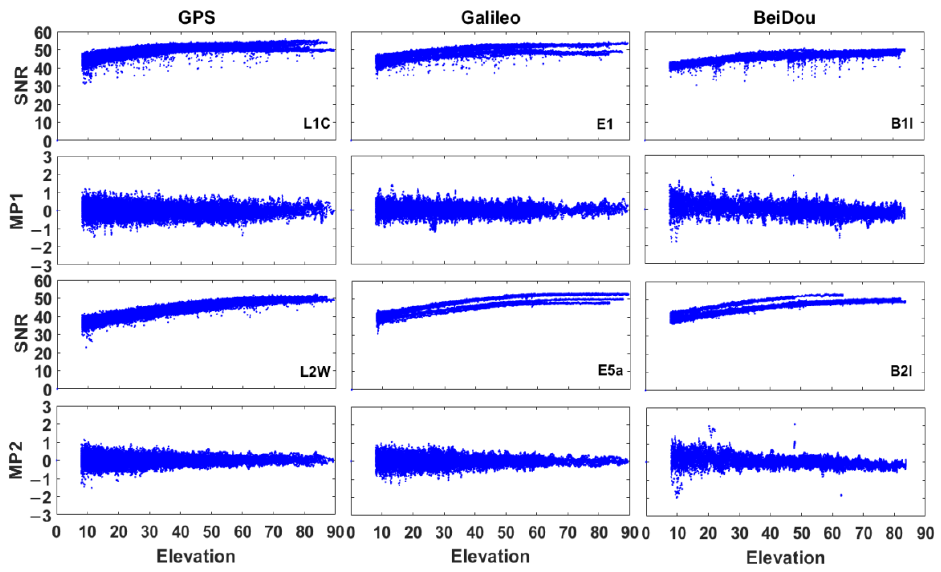
Figure 4. Signal ‐ to ‐ noise ratio (SNR, expressed as dB ‐ Hz) and pseudorange multipath (MP1 and Figure 4. Signal-to-noise ratio (SNR, expressed as dB-Hz) and pseudorange multipath (MP1 and MP2, expressed as metres , t he elevation was expressed in degrees) at HKLT station by using GPS, MP2, expressed as metres, the elevation was expressed in degrees) at HKLT station by using GPS, Galileo and BeiDou satellites. Galileo and BeiDou